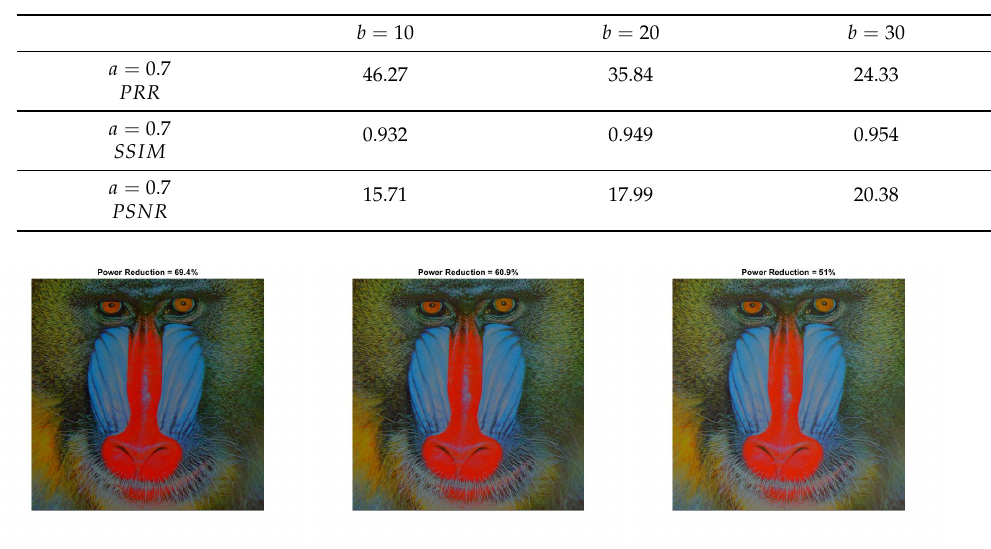
Table 8. Car image without HE for a = 0.7.